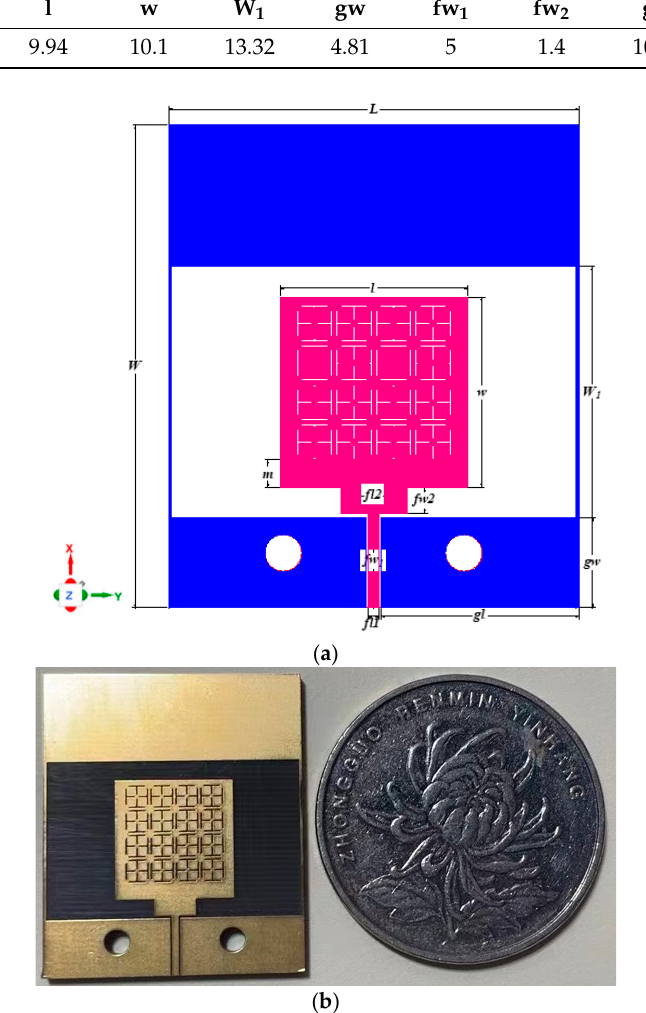
Figure 1. UWB monopole antenna: ( a ) structural diagram; ( b ) sample. Table 1. Geometrical parameters of the UWB monopole antenna.